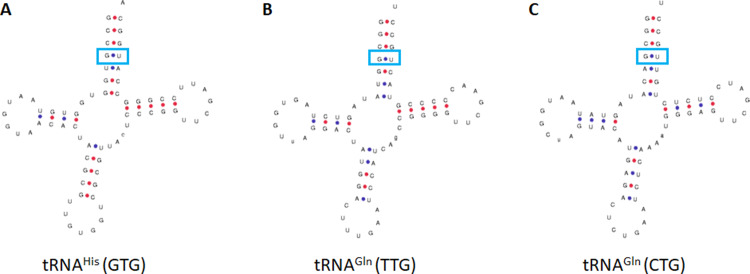
Hydra vulgaris tRNAs containing G4•U69.The predicted tRNAs from the H. vulgaris genome containing tRNAThr isodecoders on two tRNAs with different anticodons (A) CTG and (B) AGT.